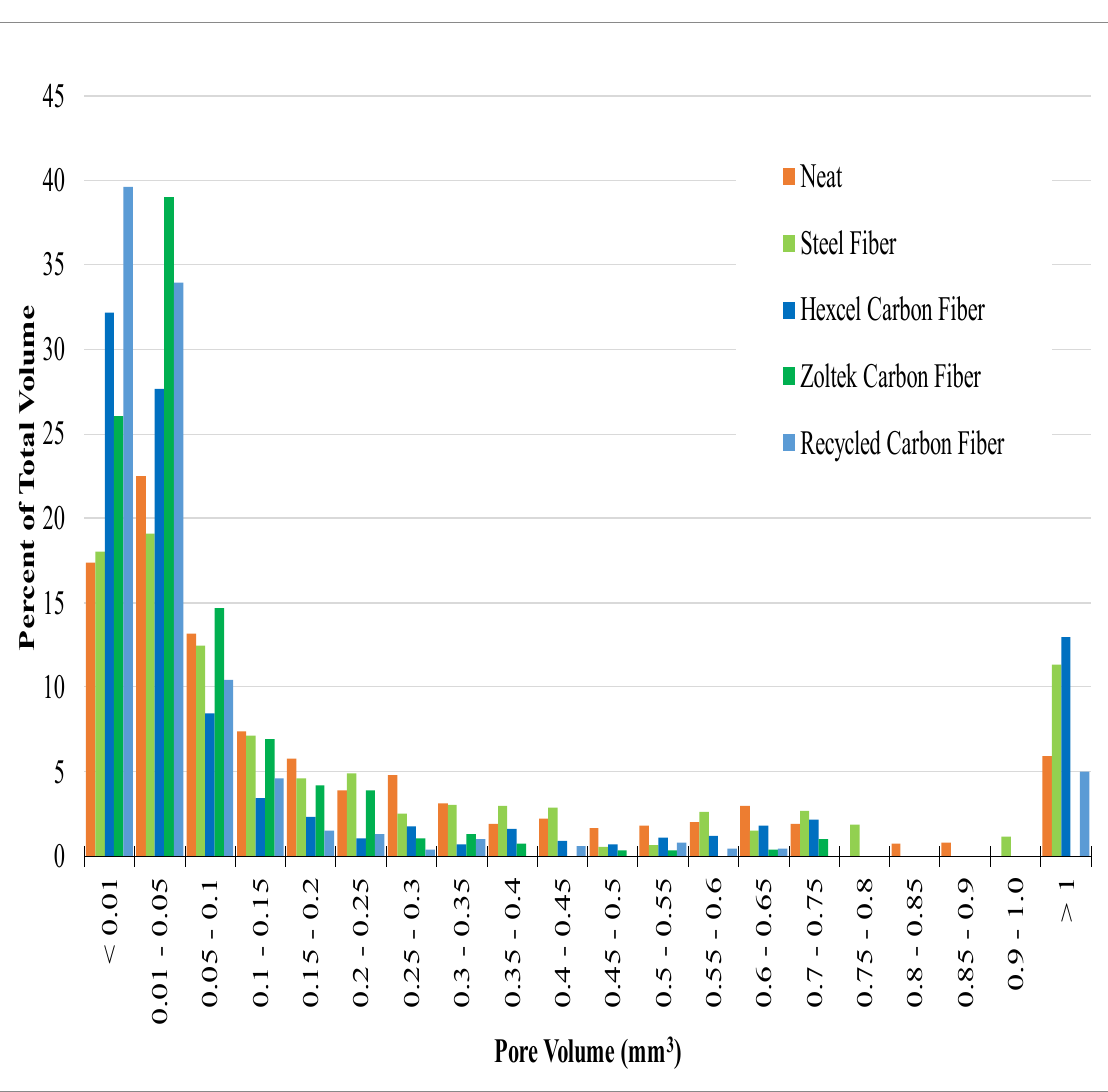
Figure 11. Pore volume distribution with respect to percent of total void